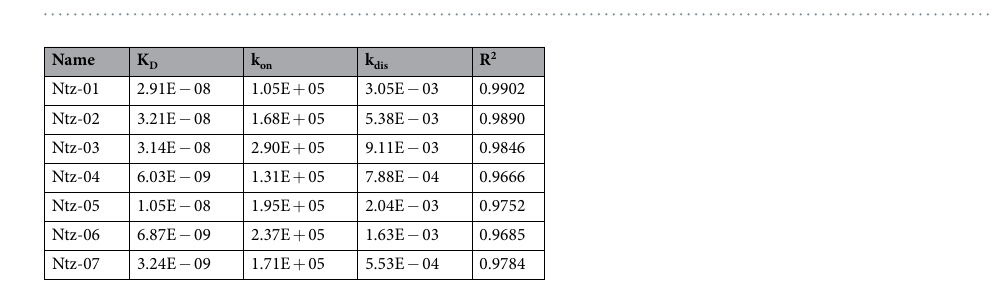
Table 4. Apparent affinity data of synthesized peptides/natalizumab as measured by biolayer interferometry